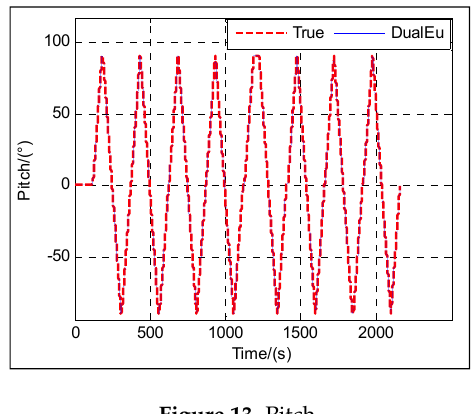
Figure 13. Pitch .